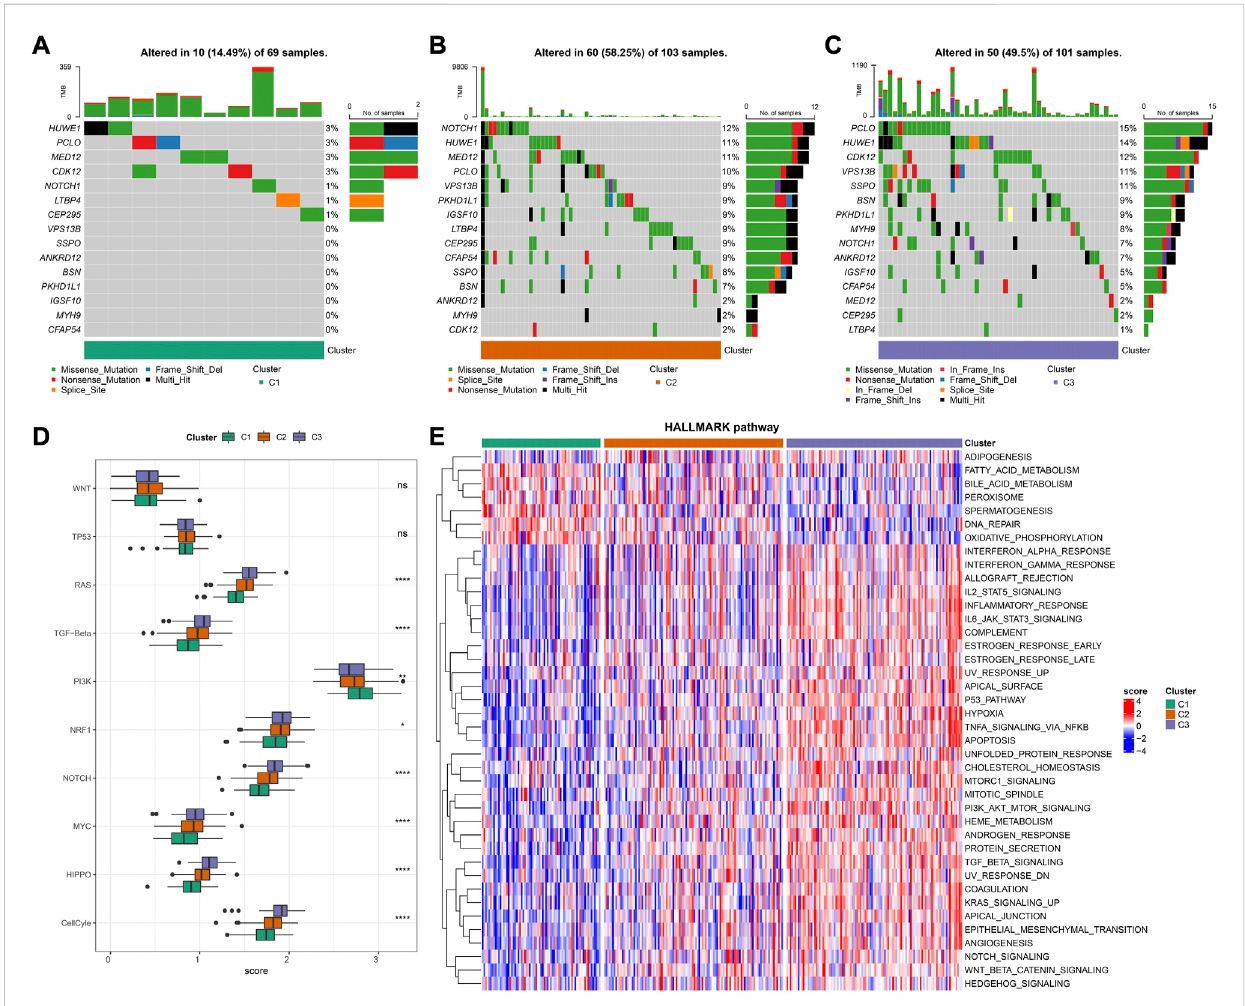
FIGURE 5 GeneticLandscapesandBiologicalPathwaysinAC1-3subtypes (A – C) Themutationfrequenciesoftop15genesinclustersAC1-3 (D) Distributionof tumorigenesis-related pathways score in AC1-3 (E) Heatmap shows pathway characteristic based on GSVA results. Red represents ssGSEA score is greater than 0 while blue represents ssGSEA score is lower than 0. ns p > 0.05; * p < 0.05; ** p < 0.01; *** p < 0.001; **** p <